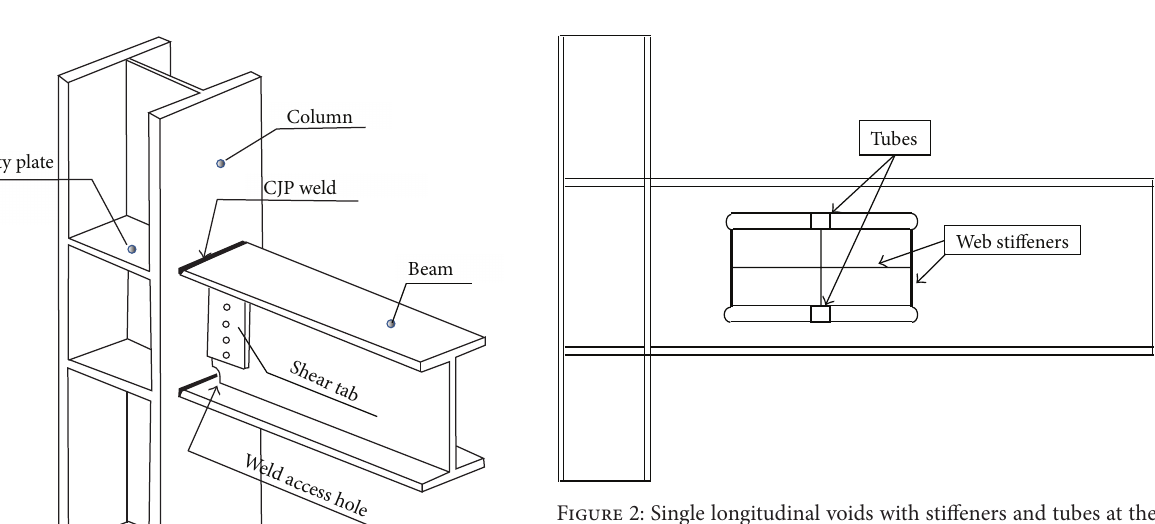
Figure 2: Single longitudinal voids with stiffeners and tubes at the center of voids proposed by Hedayat and Celikag